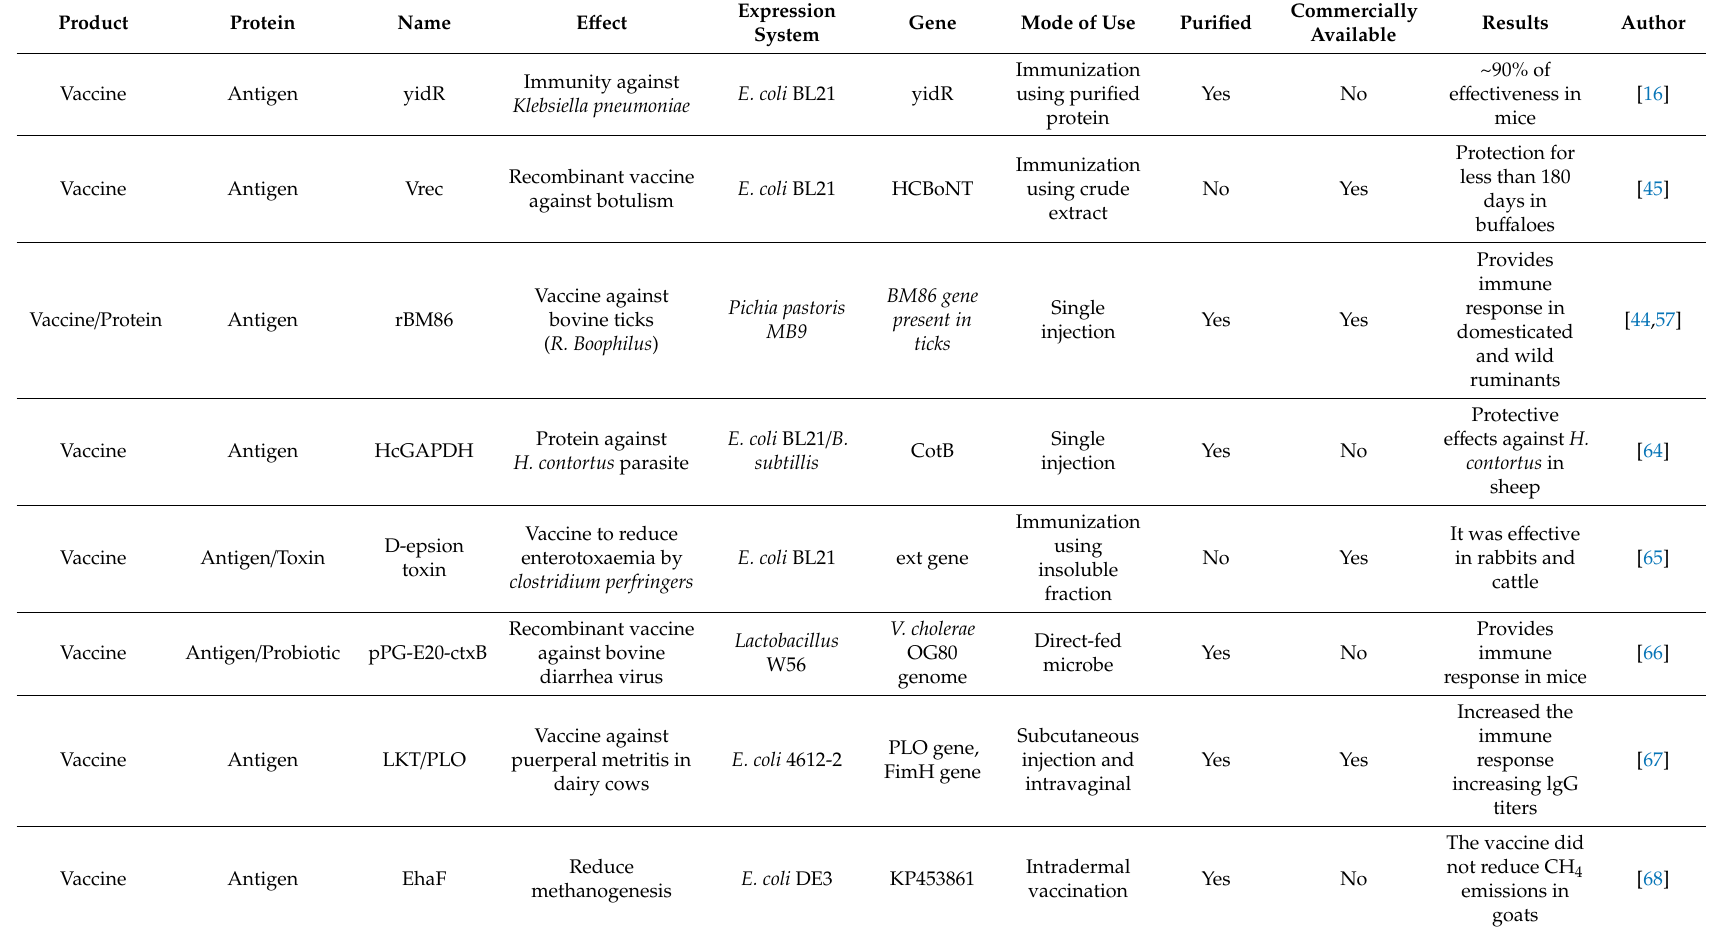
Table 2. Summary of e ff ects of recombinant vaccines on the health status of